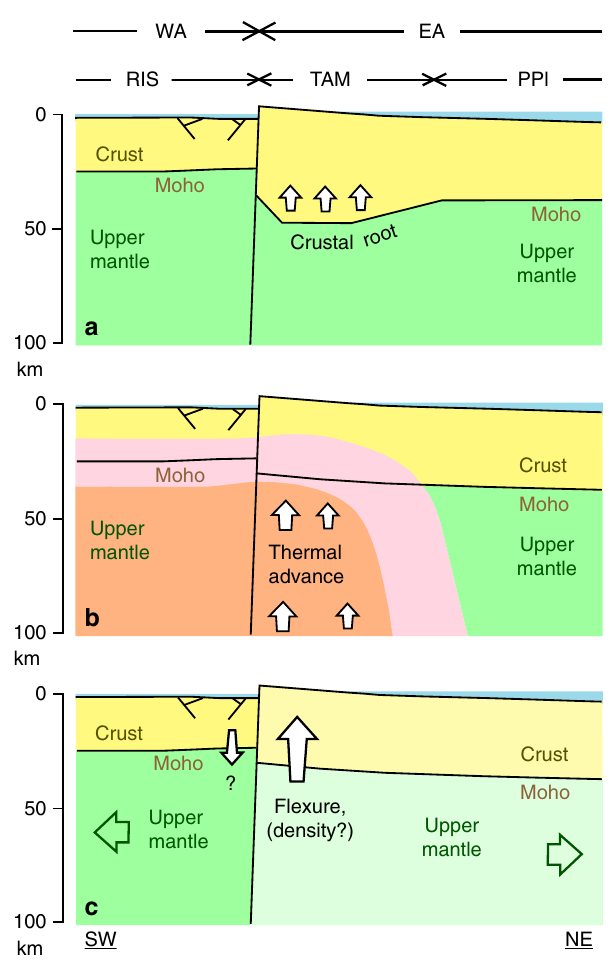
Fig. 2 Hypothetical uplift mechanisms for TAM rift shoulder. These are a buoyant uplift via low-density crustal root; b uplift via lateral heating, thermal expansion, and possible melting; c uplift via other mechanisms such as lithospheric cantilevered fl exure with or without regional density contrasts. Physiographic regions include West Antarctica (WA), East Antarctica (EA), Ross Ice Shelf (RIS), Transantarctic Mountains (TAM), and Polar Plateau (PPl). Diagram not to